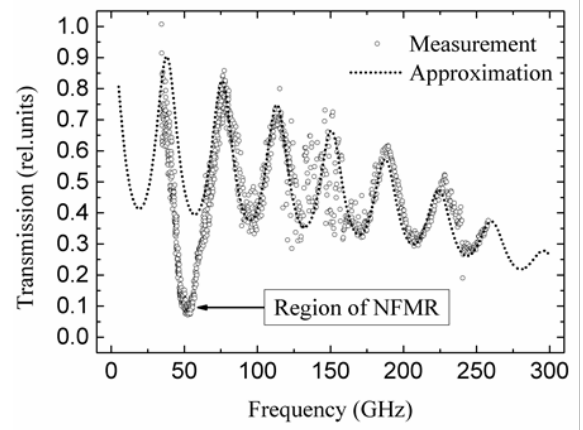
Fig. 5. Frequency dependence of the transmission coefficient of composite based on 60 wt.% BaFe 12 O 19 ferrite and water-based